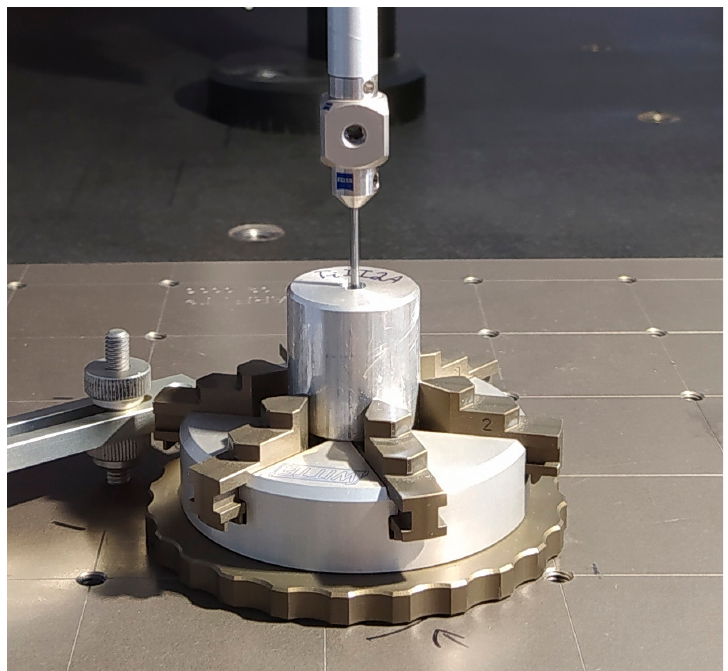
Figure 2. Measurement of a specimen mounted on the coordinate measuring machine.